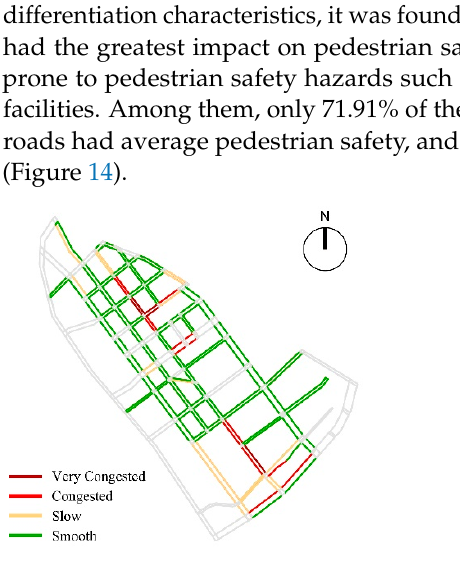
Figure 13. The analysis of pedestrian space safety: ( a ) the Obstruction of Pedestrian Safety; ( b ) the Completeness of Cross- ing Facilities; ( c ) the Impact Degree of Traffic Flow.